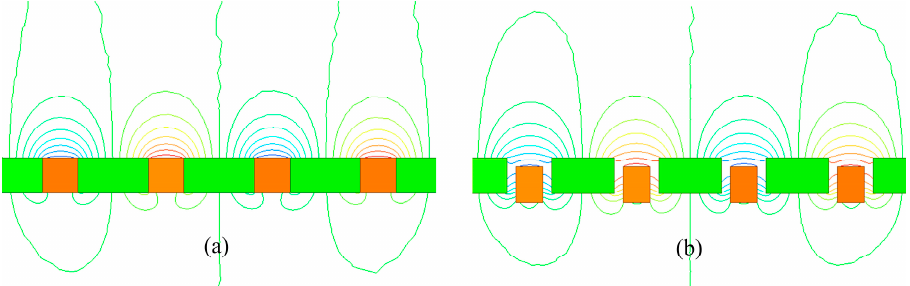
Figure 3. Flux lines distribution. ( a ) The traditional Halbach magnet array; ( b ) the novel magnet array with gaps and staggers.